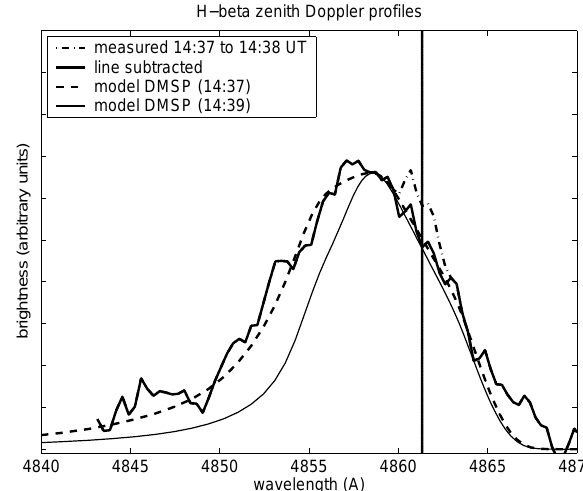
Fig. 6. Integrated H β profiles showing geocoronal contamination when H β emission is weak after 15:46 UT.